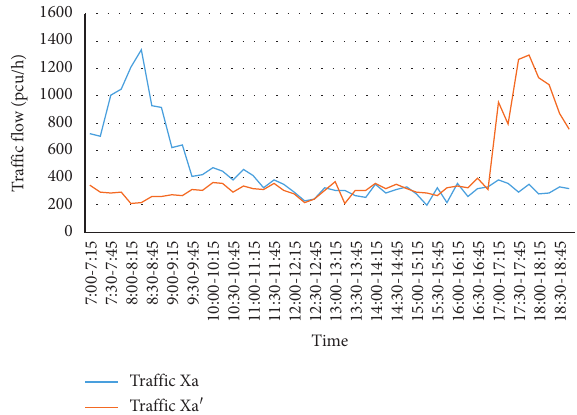
Figure 2: Traffic volume of the Lihu Avenue tidal section.